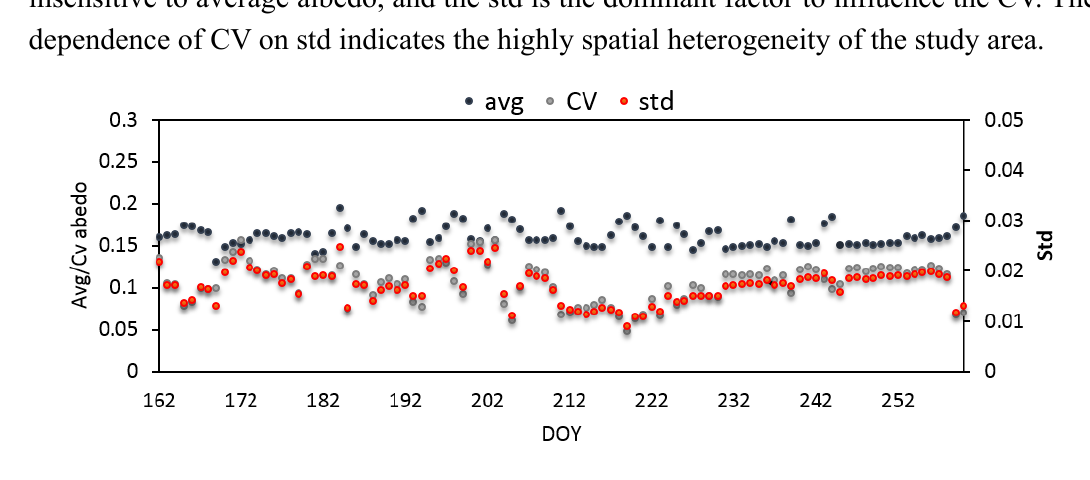
Figure 4. Time series of 16 sites-averaged surface albedo in the study area with standard deviation (std) and coefficient of variation